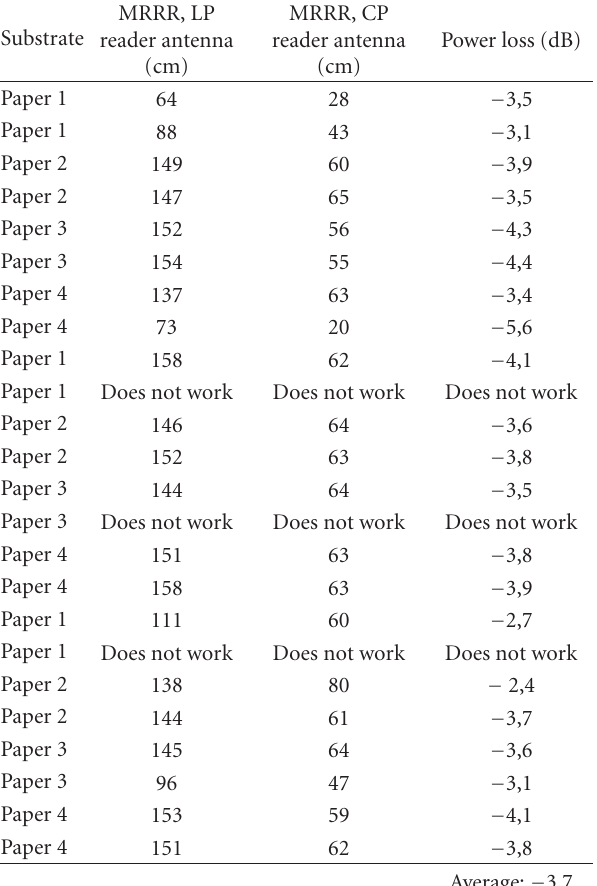
Table 4: The MRRR values and power losses measured in air. Table 5: The best MRRR values measured with linearly polarized reader antenna.